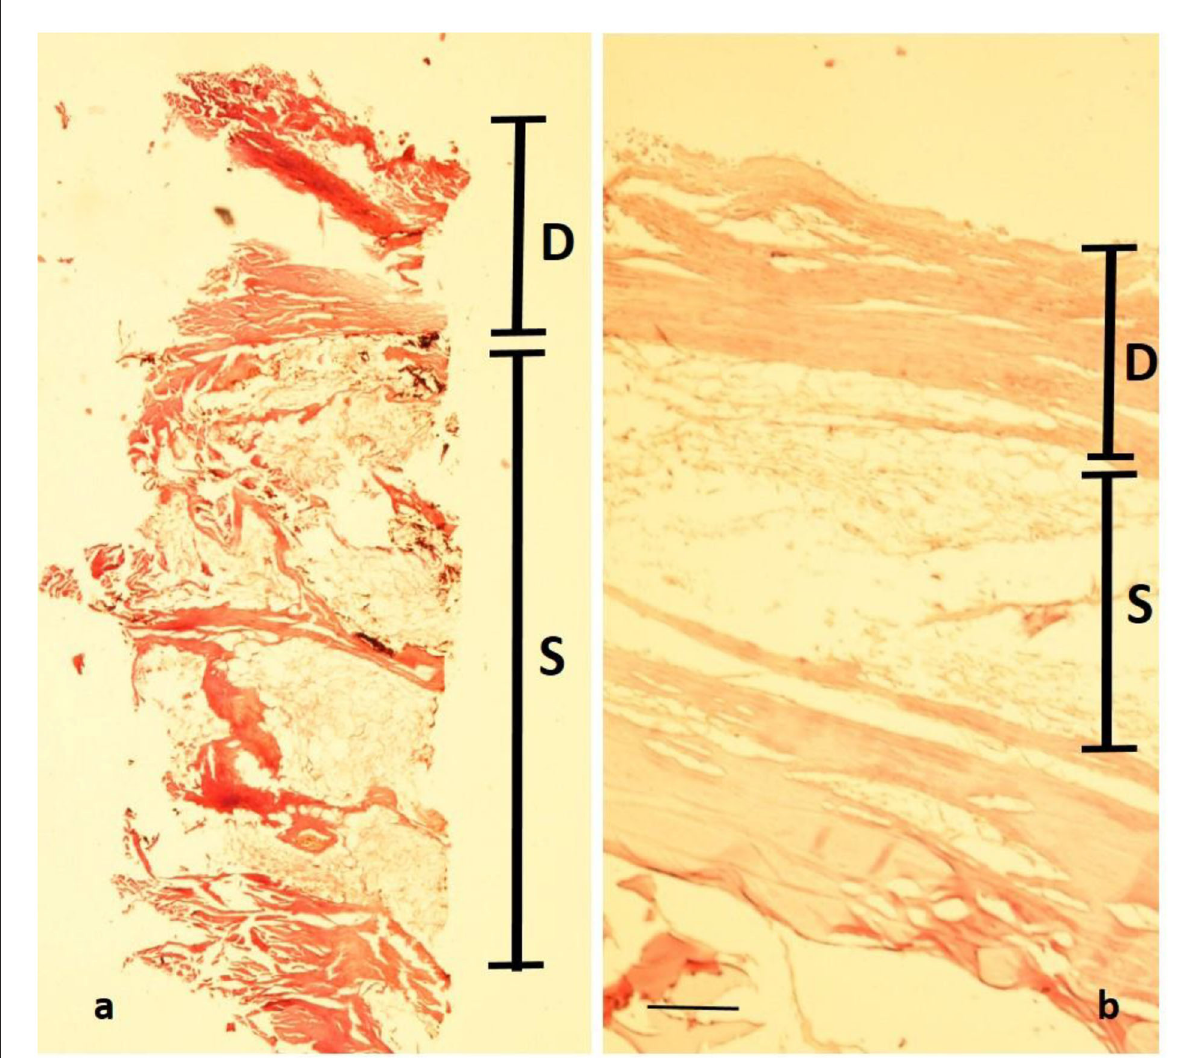
FIGURE11 Histopathology of the mummy’s skin following rehydration and embedding: although the epidermis has been lost, a well-preserved dermal collagenous connective tissue is seen (“D”) which is followed by subcutaneous fat tissue (“S”). (a) Cross-section of the mummy sample; (b) similar samples (age- and site-matched) from an aristocratic infant mummy from South Germany (Staining: H&E; bar: 500 µ